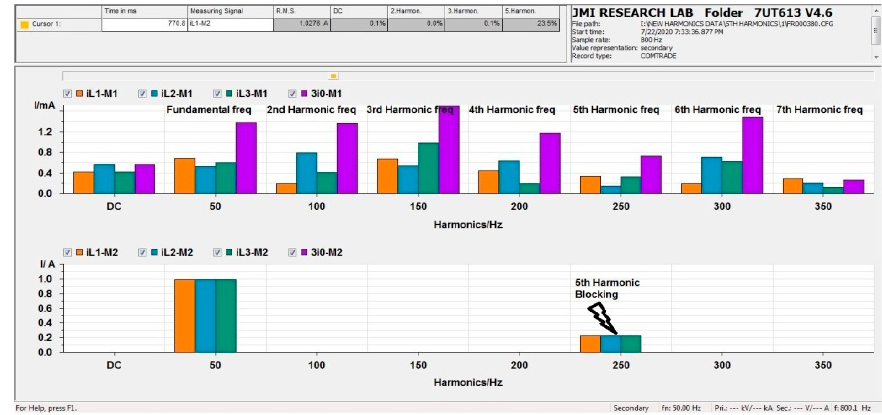
Figure 25. 5th HB at 1000 mA Rated current & 37% of Inrush current condition.